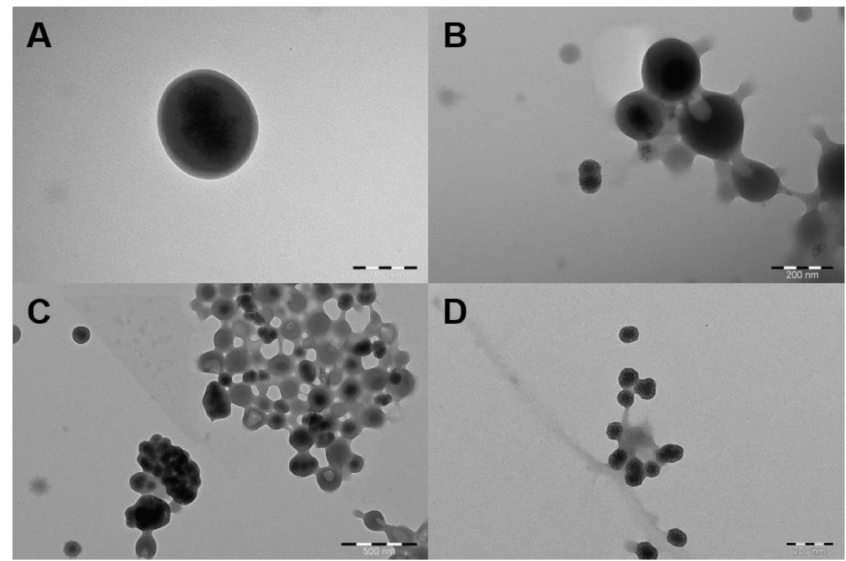
Figure 4. TEM images representing SpAcDEX polymer encapsulation results. A: S1, B: S2, C: S3, and D: S5. Scale bars: ( A ) 100 nm, ( B ) 200 nm and ( C ) 500 nm, ( D ) 200